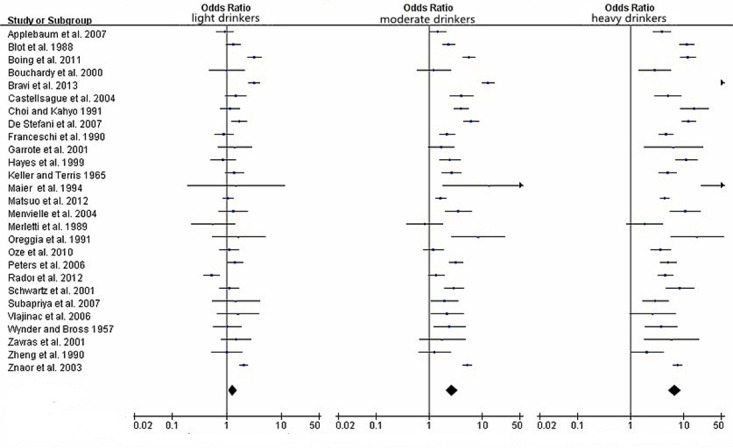
Forest plots for pooled Odds ratios (ORs) and the corresponding 95% confidence intervals (CIs) of HNC cancer risks for light, moderate and heavy drinkers.